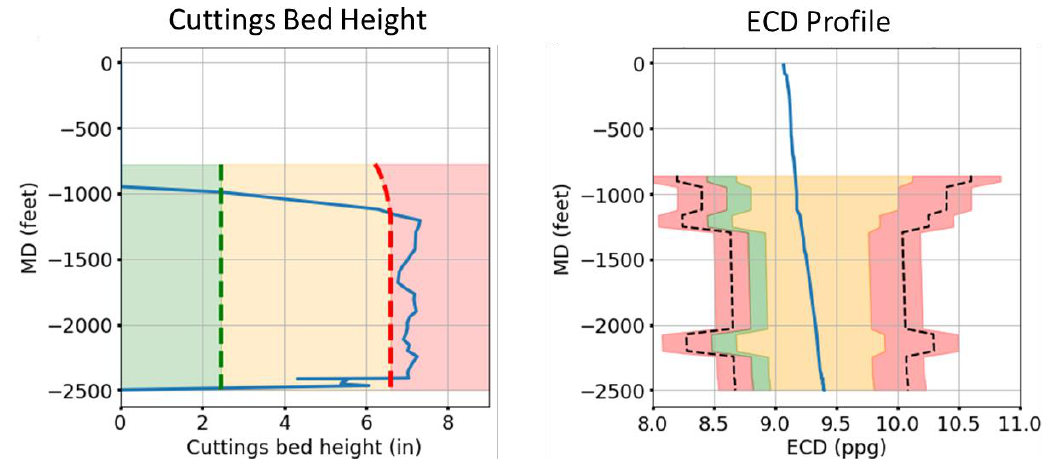
Figure 18. State of the borehole at the end of the circulation cycle.